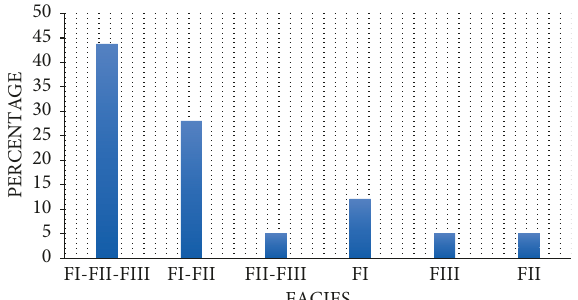
Figure 6: Distribution of medicinal species by facies in the Bigoudine watershed. FI: facies I; FII: facies II; FIII: facies III.